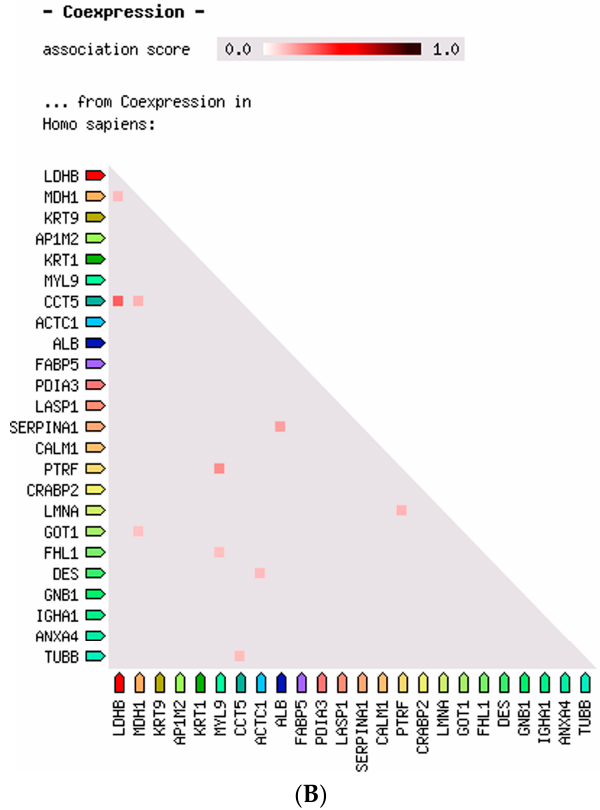
Figure 3. Prediction by STRING database: ( A ) protein interactions based on confidence prediction and ( B ) co-expression of upregulated proteins in the leiomyoma.